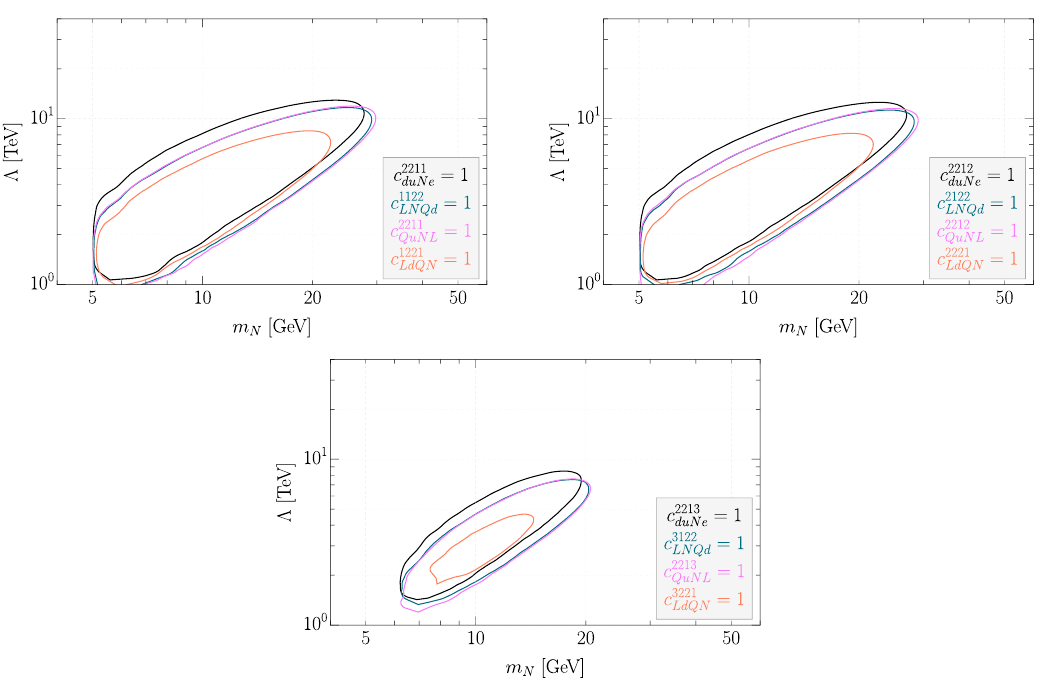
Figure 3 . The same as figure 2, but for operators with second-generation quarks only.